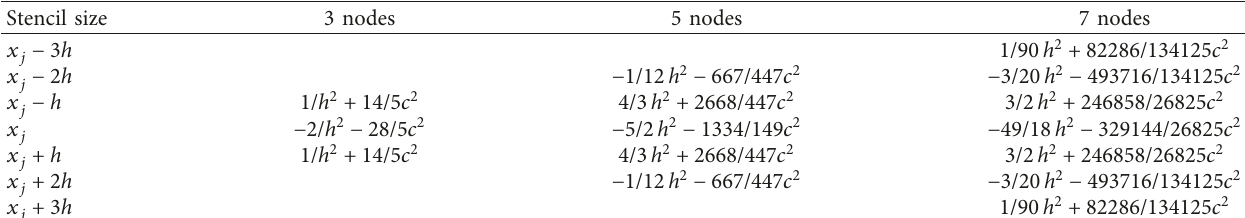
Table 2: Series expansions of IQ-RBF-FD weights for u ″ .